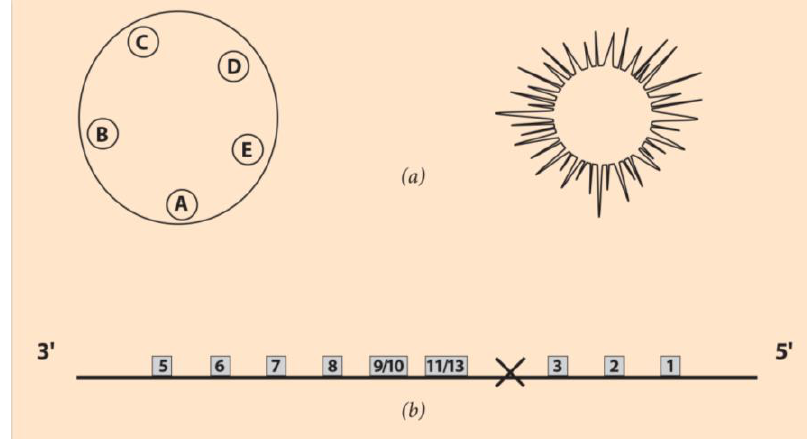
Figure 3. Developmental stages of the echinoderms. ( a ) (Left) Holopneustes purpuratusvestibula larva with A, B, C, D, E the podia locations (adapted from [36]. (Right) Juvenile sea urchin. ( b ) The Hox gene cluster ordering of the sea urchin. Hox4 is missing (hole), and the normal gene ordering is reshuffled. The finite line with distinct ends is substituted by this rotationally symmetric contour